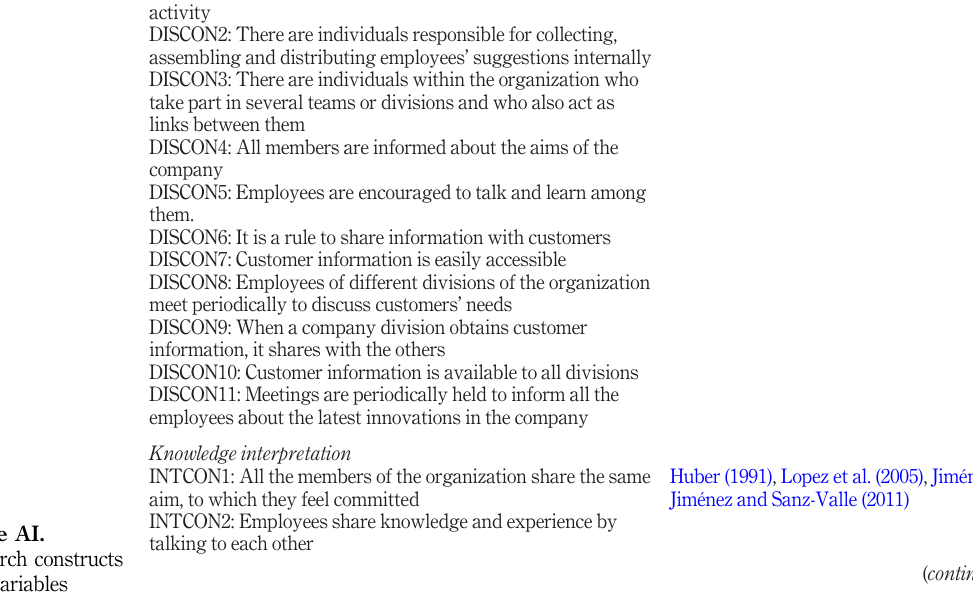
Table AI. Research constructs and